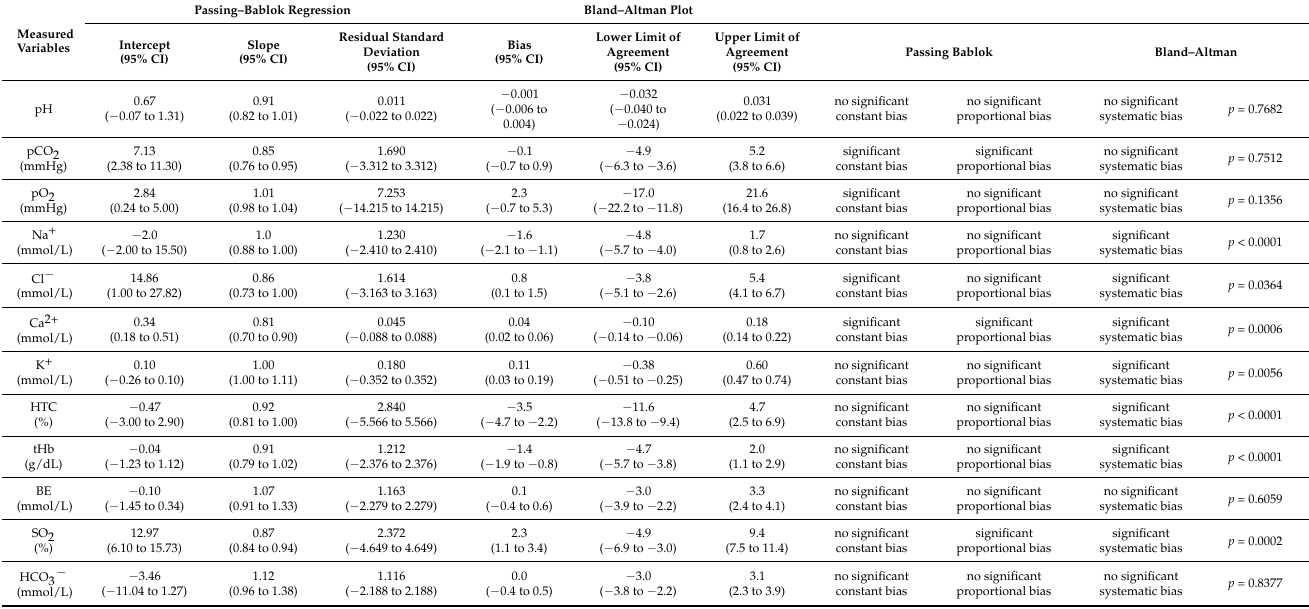
Table 4. Results of the Passing–Bablok regression and the Bland–Altman plots resulting from the comparison between the GEM5000 and the epoc